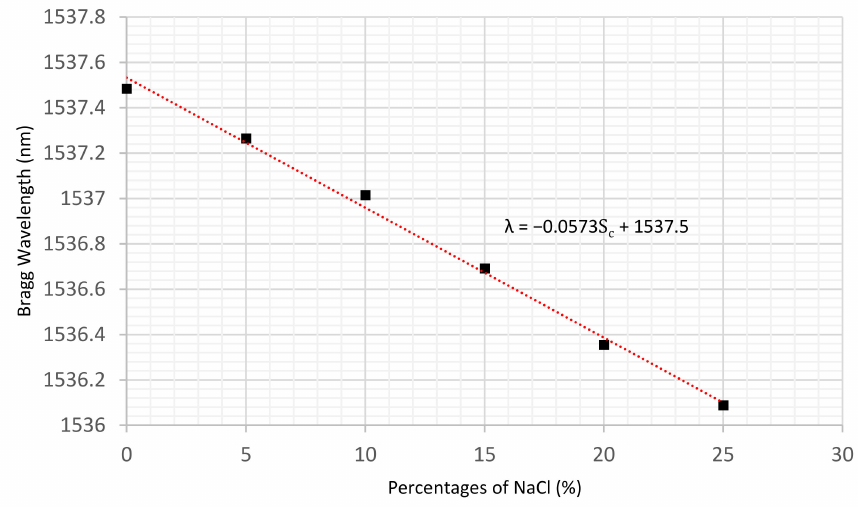
Figure 11. The linear regression of the polymer sensor’s response to salt concentration changes in